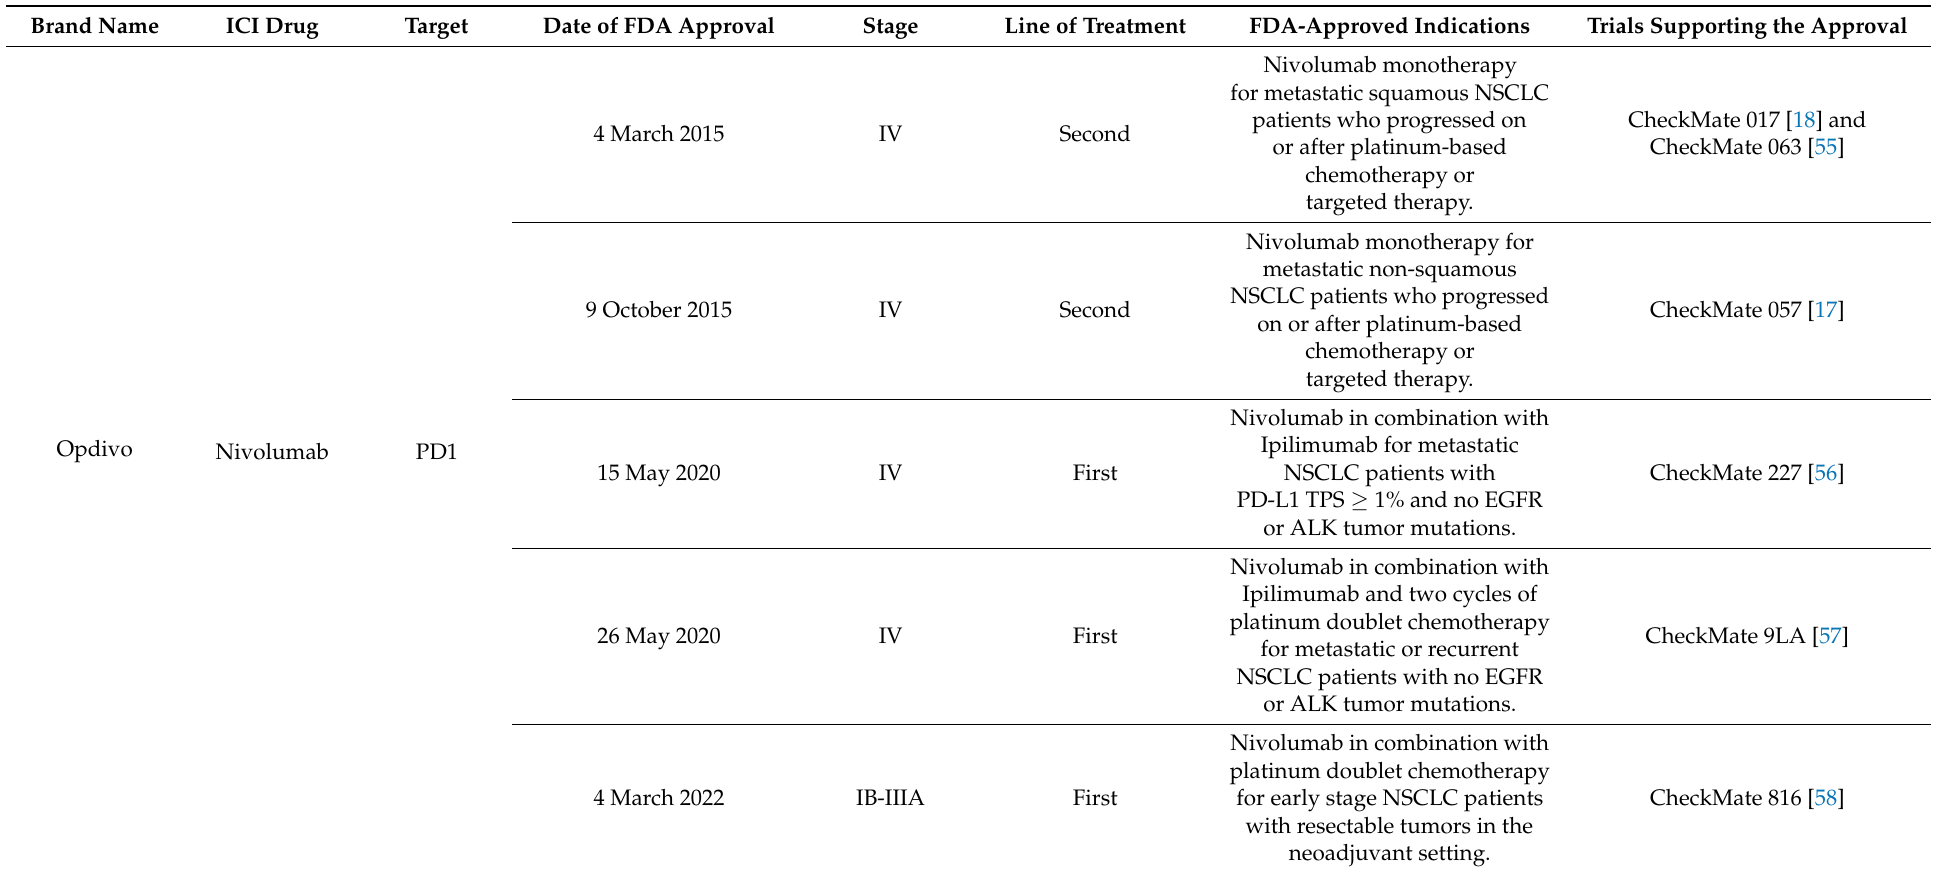
Table 1. FDA-approved immune checkpoint Inhibitors for treatment of